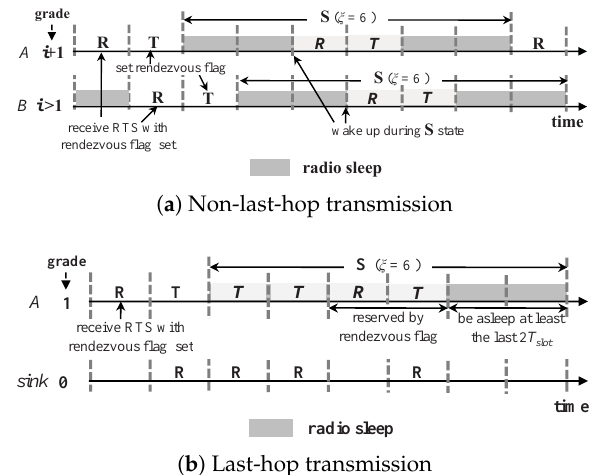
Figure 5. Adaptive Schedule Maintenance (ASM) scheme, for ( a ) Non-Last-Hop Transmission (NLHT) and ( b )